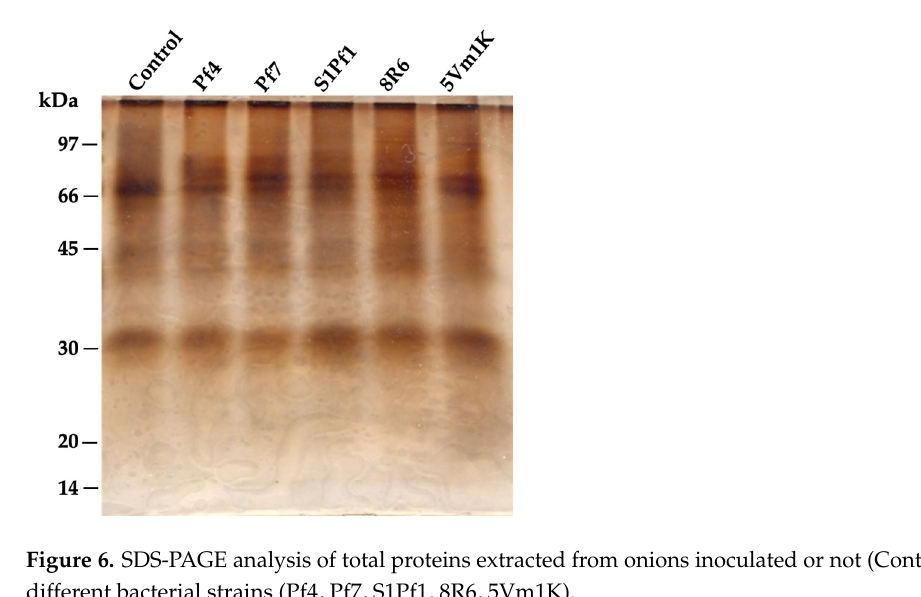
different bacterial strains (Pf4, Pf7, S1Pf1, 8R6,